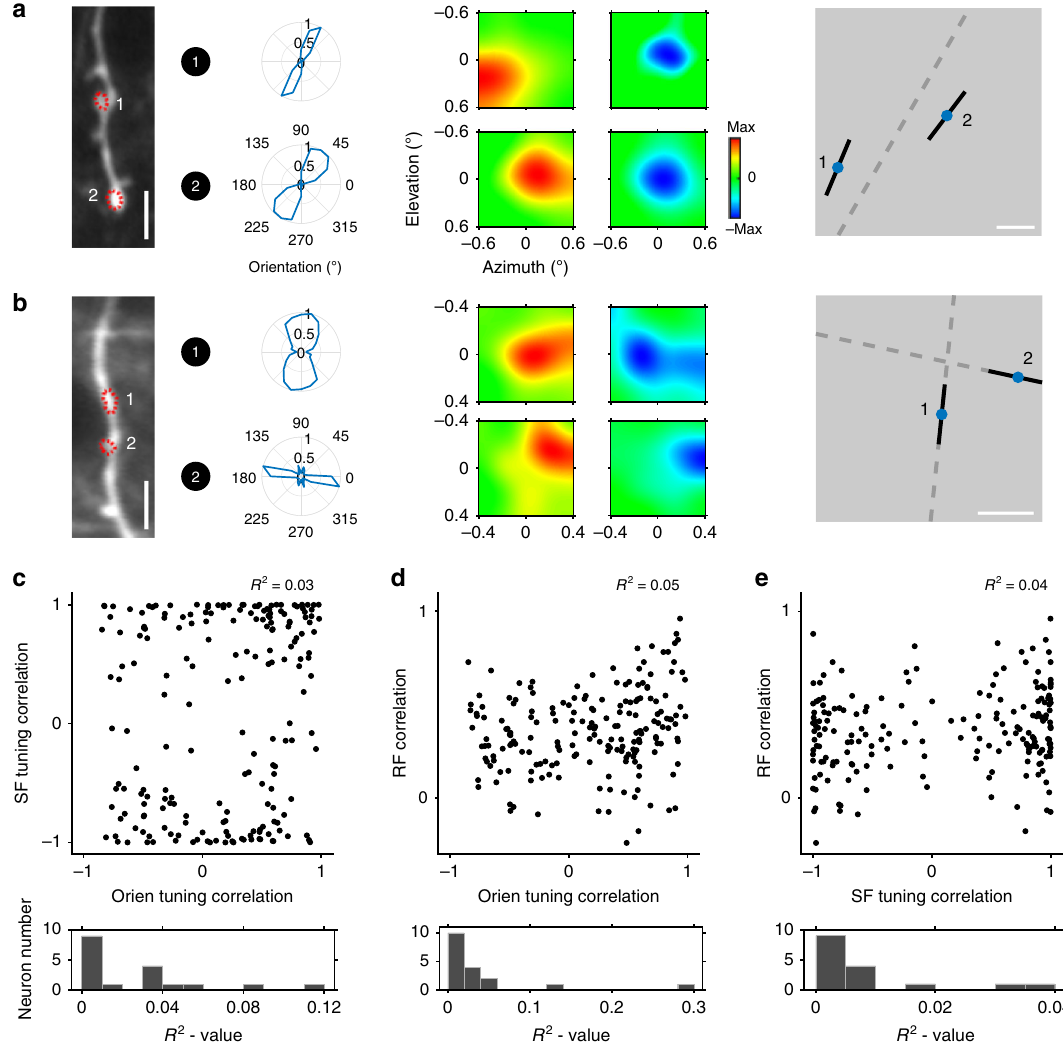
Fig. 4 Diversity of dendritic inputs among multi-feature dimensions. a Two ROIs on one dendritic draft share similar orientation preferences while having distinct RFs. Left, sample dendrite (averaged across 1000 frames at 114 μ m on Day 86) and target ROIs. Scale bar, 5 µ m. Middle, the corresponding orientation preferences and RFs (red, ON; blue, OFF). Right, preferred orientation (black) overlaid at the site of each RF center (blue) for each ROI. Scale bar, 0.2 degree. b Another sample dendrite (averaged across 1000 frames at 127 μ m on Day 71) with an associated ROI pair. Those ROIs have both different orientation preferences and different RFs. c Inter-ROI SF tuning correlation as a function of orientation tuning correlation. Top, scatter plot from a sample neuron; R 2 value from linear regression. Bottom, distribution of R 2 value from all collected neurons. d Inter-ROI RF correlation vs. orientation tuning correlation. e Inter-ROI RF correlation vs. SF tuning